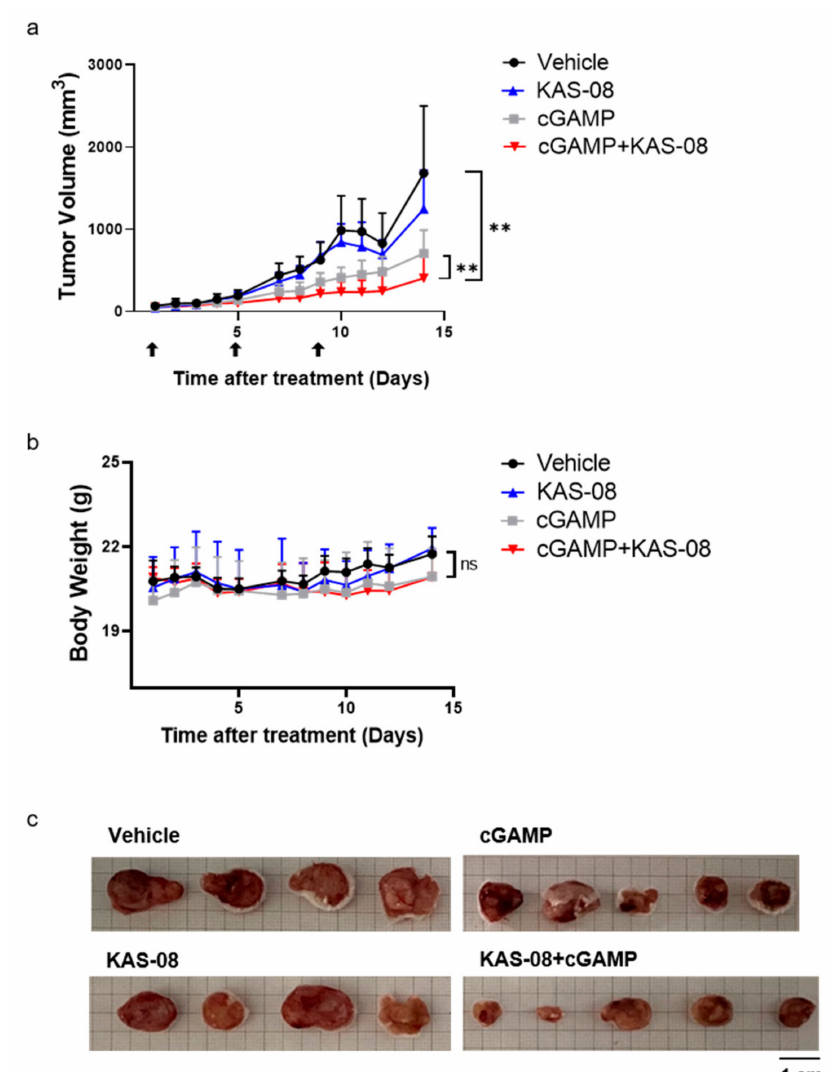
Figure 7. Evaluation of the synergy anti-cancer effect of KAS-08 by combination with cGAMP in CT26 bearing mouse. Balb/c mice were administrated by four different groups. Vehicle ( n = 4), KAS-08 ( n = 4, 15 mg/kg, i.v.), cGAMP ( n = 5, 2 µ g, i.t.), and KAS-08 ( n = 5, 15 mg/kg, i.v.) with cGAMP (2 µ g, i.t.). cGAMP was injected three times at the indicated days. KAS-08 was injected eight times every one or two days. ( a ) Tumor volume of four different groups. Paired t -test for statistics. **: p < 0.01. ( b ) Change in body weight in the four different groups. Two-way ANOVA for statistics. ns: not significant. Graphs show the mean and SD. ( c ) Image of isolated tumor from mice after 14 days of